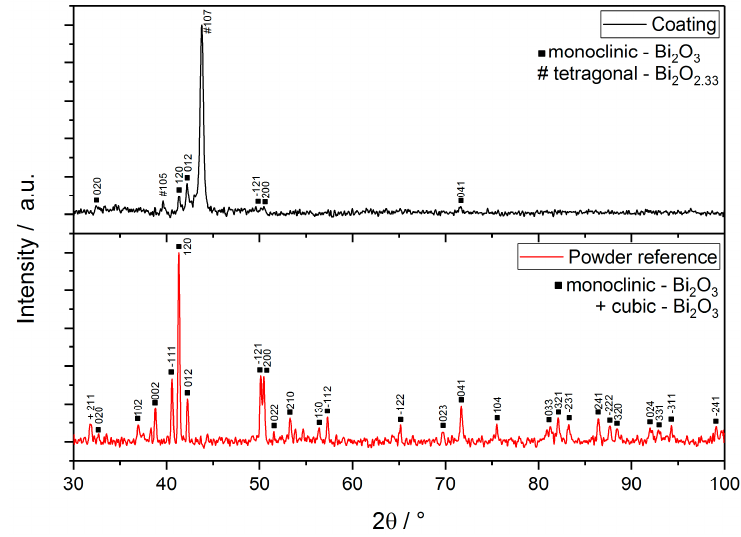
Figure 2. XRD plot of coating and powder reference, with Figure 2 . XRD plot of coating and powder reference, with ▪ monoclinic Bi Figure 2 . XRD plot of coating and powder reference, with ▪ monoclinic Bi 2 O 3 , + cubic Bi 2 O 3 and # tetragonal Bi 2 O 2.33 tetragonal Bi 2 O 2.33 .